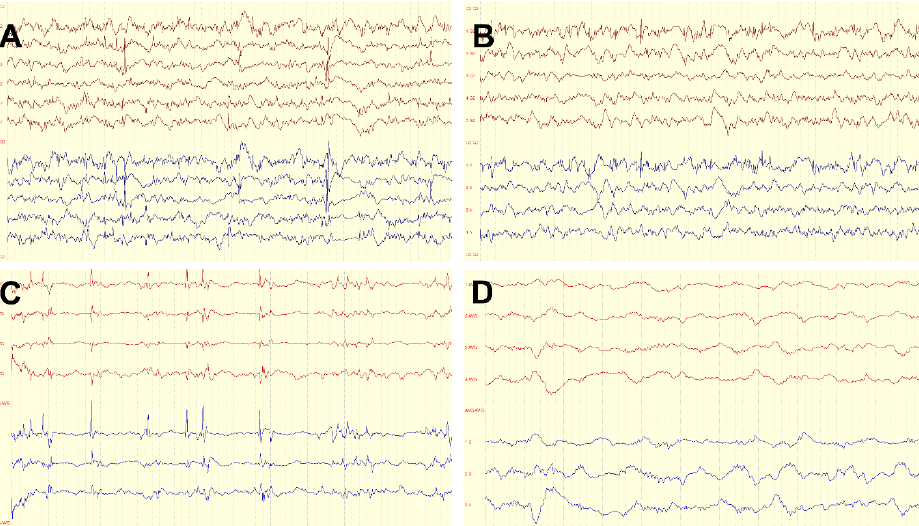
Figure 2. Intraoperative ECoG findings in patients with epilepsy due to LEAT. Red lines: monopolar montage, blue lines: bipolar montage. ( A ) A 16-year-old male with epilepsy since six months, pre- senting with first bilateral tonic-clonic seizures and suspected DNET in the right frontal lobe. ECoG before resection showing frequent spiking with maximum at Electrode 2. ( B ) The same patient fol- lowing tumor resection; ECoG showing persistent spiking with maximum at Electrode 1. Gross total resection was limited in the frontotemporal resection margins due to a suspected dominant right hemisphere; patient had a seizure relapse one-year post surgery following drug withdrawal. ( C ) A six-year-old girl suffering from left temporal lobe epilepsy since two years of age; histopathology confirmed ganglioglioma with associated focal cortical dysplasia. ECoG before resection with fre- quent spiking. ( D ) The same patient after gross-total resection showing diffuse slowing without spiking; patient is seizure-free, and ASMs are reduced.